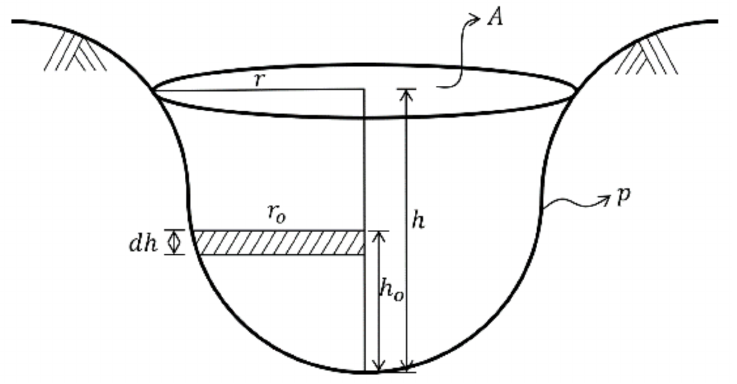
Figure 2. The Structure of a